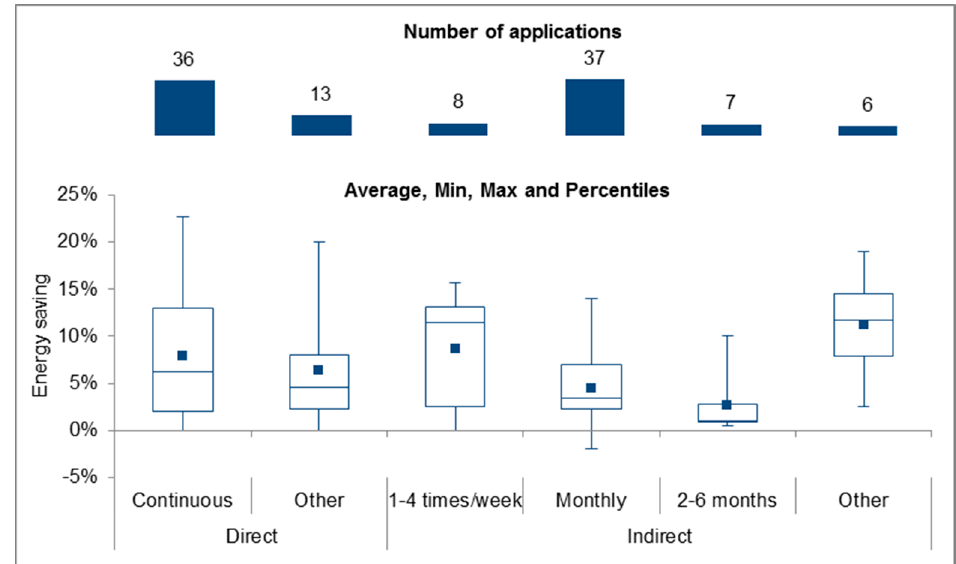
Figure 8. Number of studies and statistical analysis of energy savings, per type of feedback, and interaction frequency (based on 107 out of 114 feedback applications). The “Other” category includes daily and mixed frequencies.